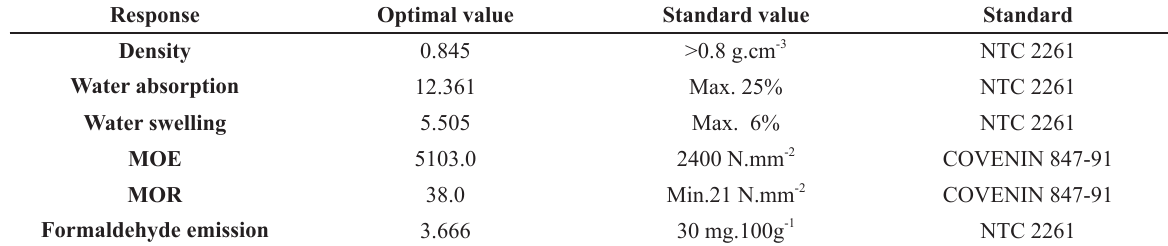
Predicted response